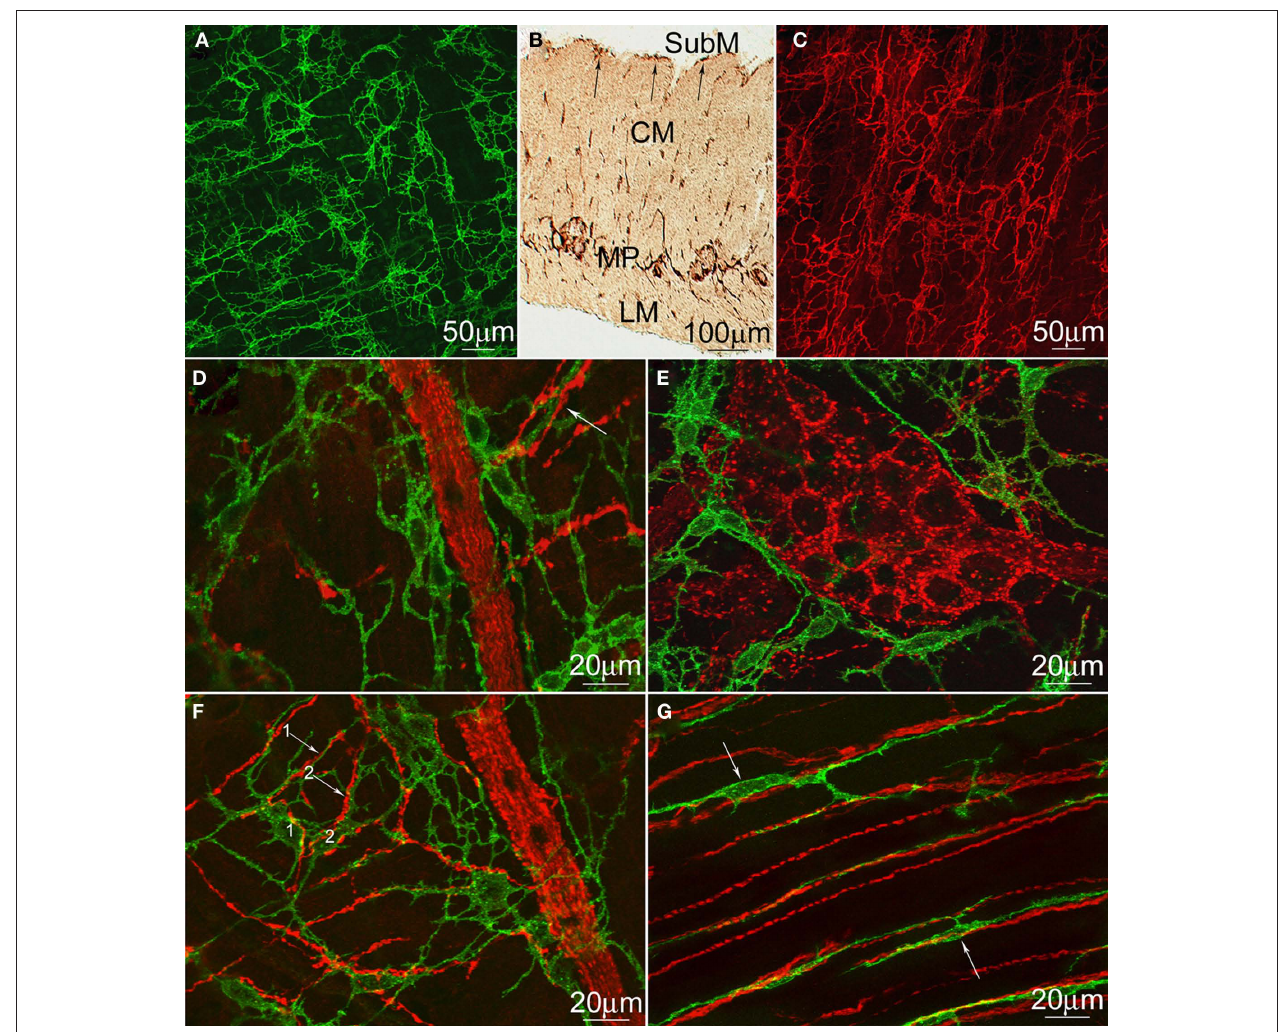
FIgurE 4 | Distribution of rat and mouse colonic ICC and cholinergic neurons. c-Kit immunostaining of ICC–MP (A) and ICC–SMP (C) in whole- mounts of the rat colon and a cross-section (B) . LM, longitudinal muscle; MP, myenteric plexus; CM, circular muscle; SubM, submucosa. Both ICC–SMP and ICC–MP form dense networks at the level of the submuscular plexus and the myenteric plexus respectively. ICC–SMP run parallel to the circular muscle layer. (D–g) Double immunostaining of VAChT (red) and c-Kit (green) to show